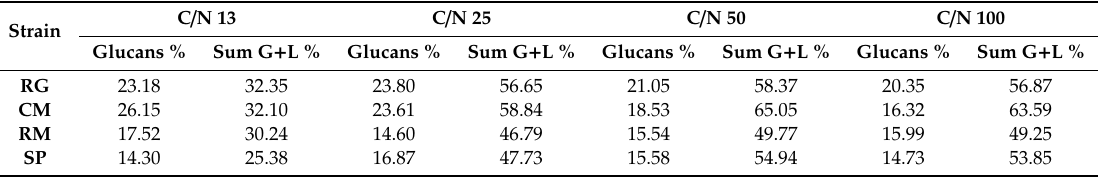
Table 5. Summary production of beta-glucans and lipids on glucose at di ff erent C / N ratios. C / N 13 Strain Glucans %